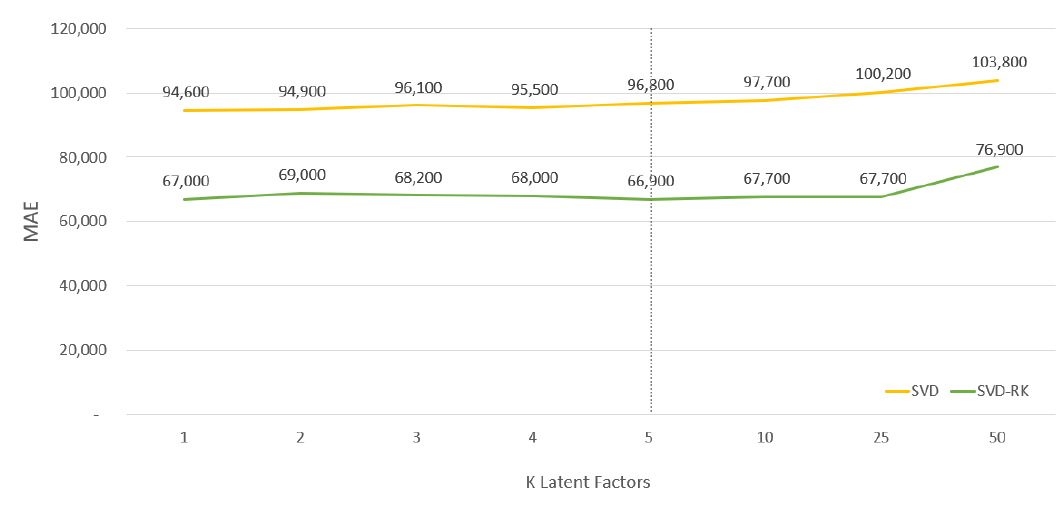
Figure 7. Latent Factor